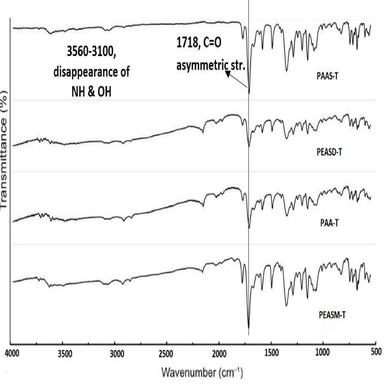
The FT-IR results of the thermoplastic PI matrices.